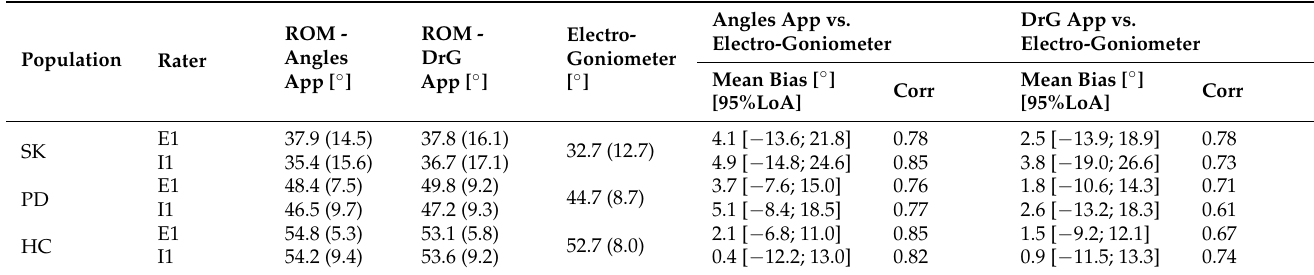
Table 4. Concurrent validity of the range of motion measurements acquired by the Angles and DrGoniometer applications in the three studied populations, and agreement between expert and non-expert assessments (E1, I1) with respect to the electro-goniometer.